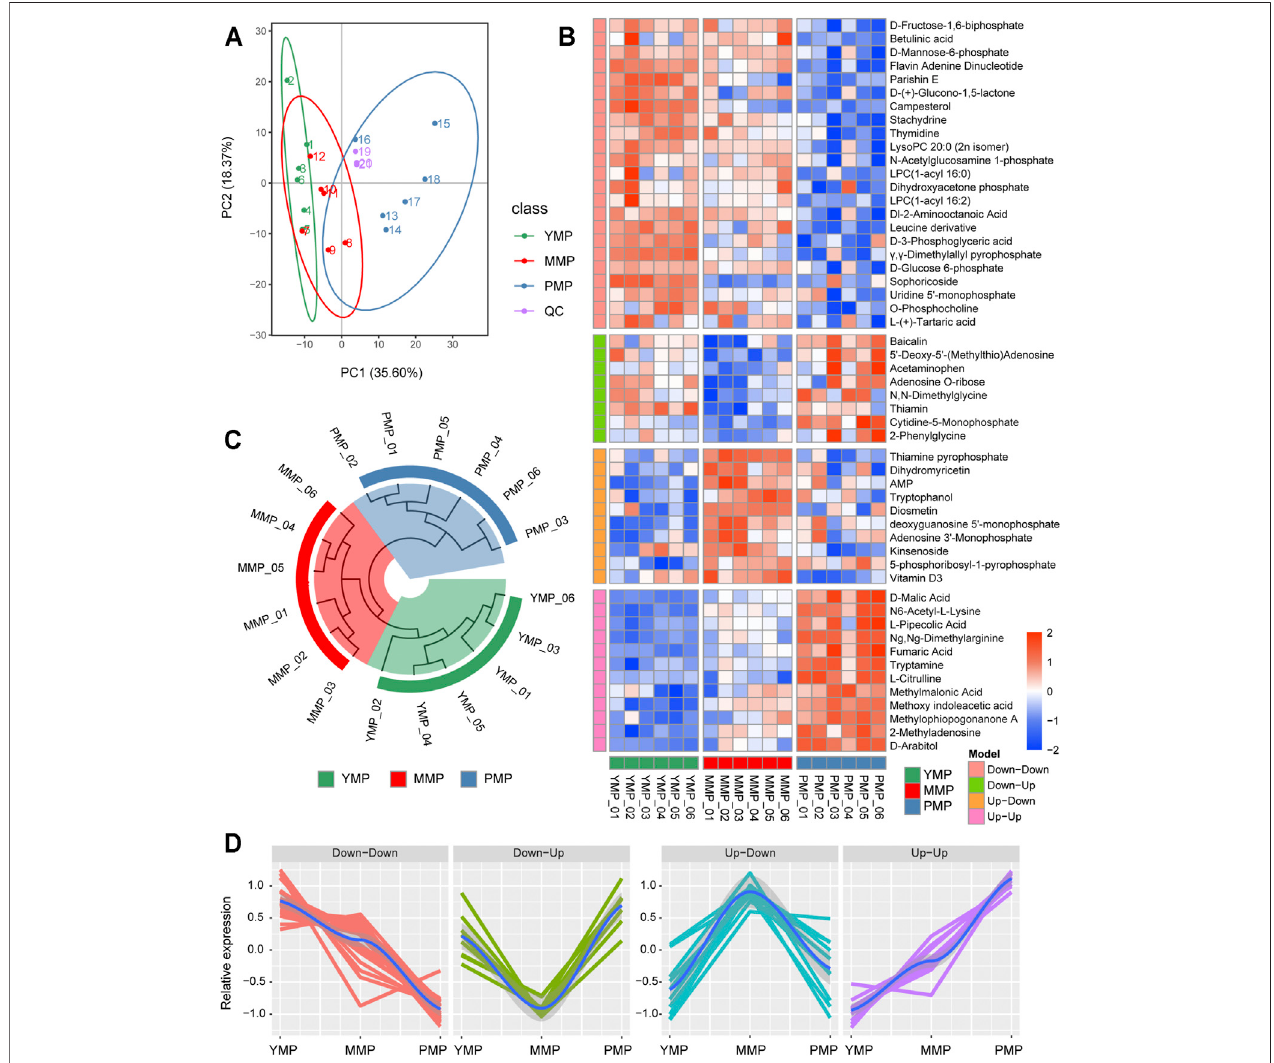
FIGURE 2 | Dynamic metabolomics changes during the three growth stages of M. sextelata . (A) : PCA analysis of the samples during the three stages and the QC reference. (B) Theheatmapofmetabolitesshowingdistinctpatternsamongthethreegrowthstages.Thetime-dependenttrendanalysisdividesthemetabolitesintofour different patterns: Up − Up, Up − Down, Down − Up, and Down − Down. (C) The circular clustering tree consists of nine samples, considering differential metabolites as the feature vector. (D) A line chart showing the relative expression patterns of the potential marker metabolites of each